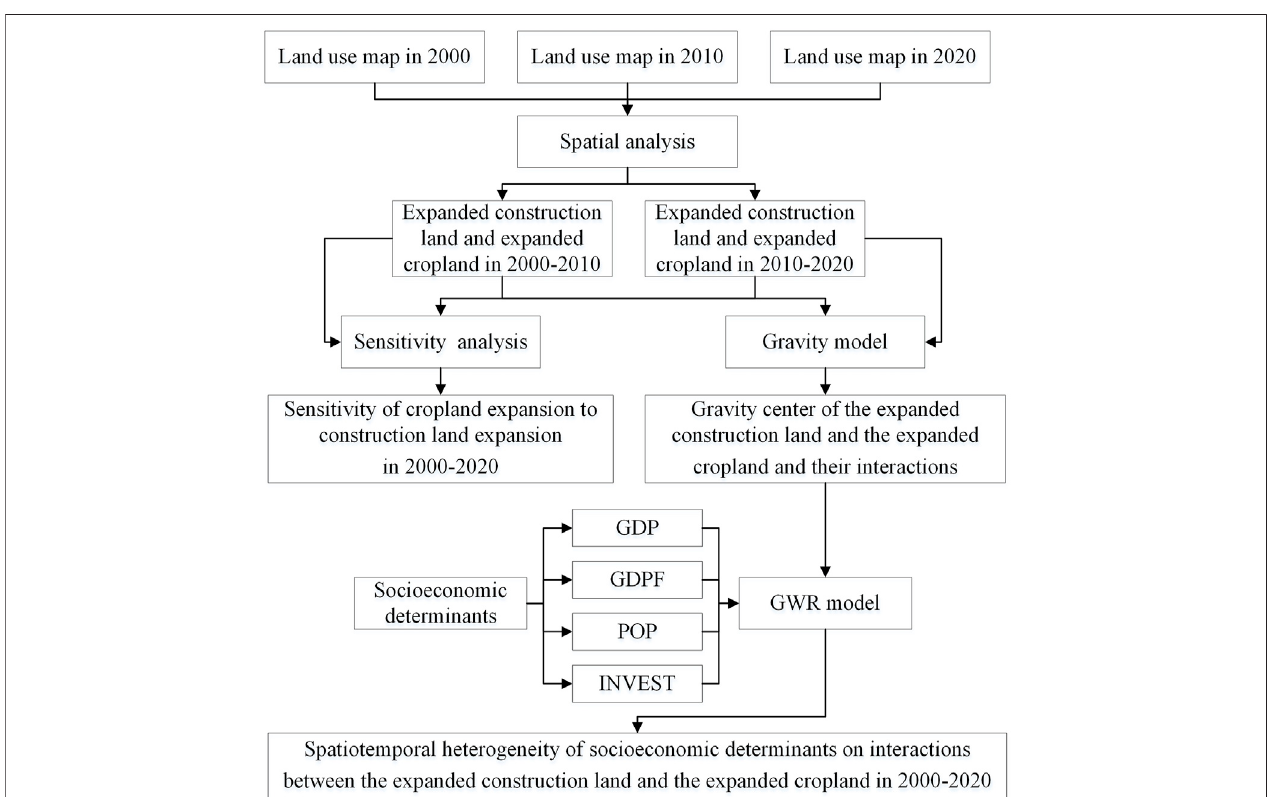
FIGURE 2 | Research